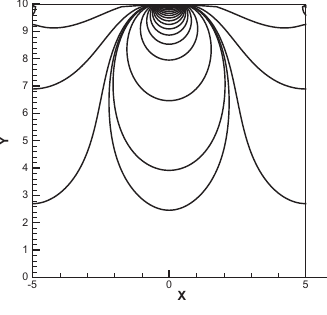
Figure 12. Pressure contours for the two-dimensional problem adding the stabilization